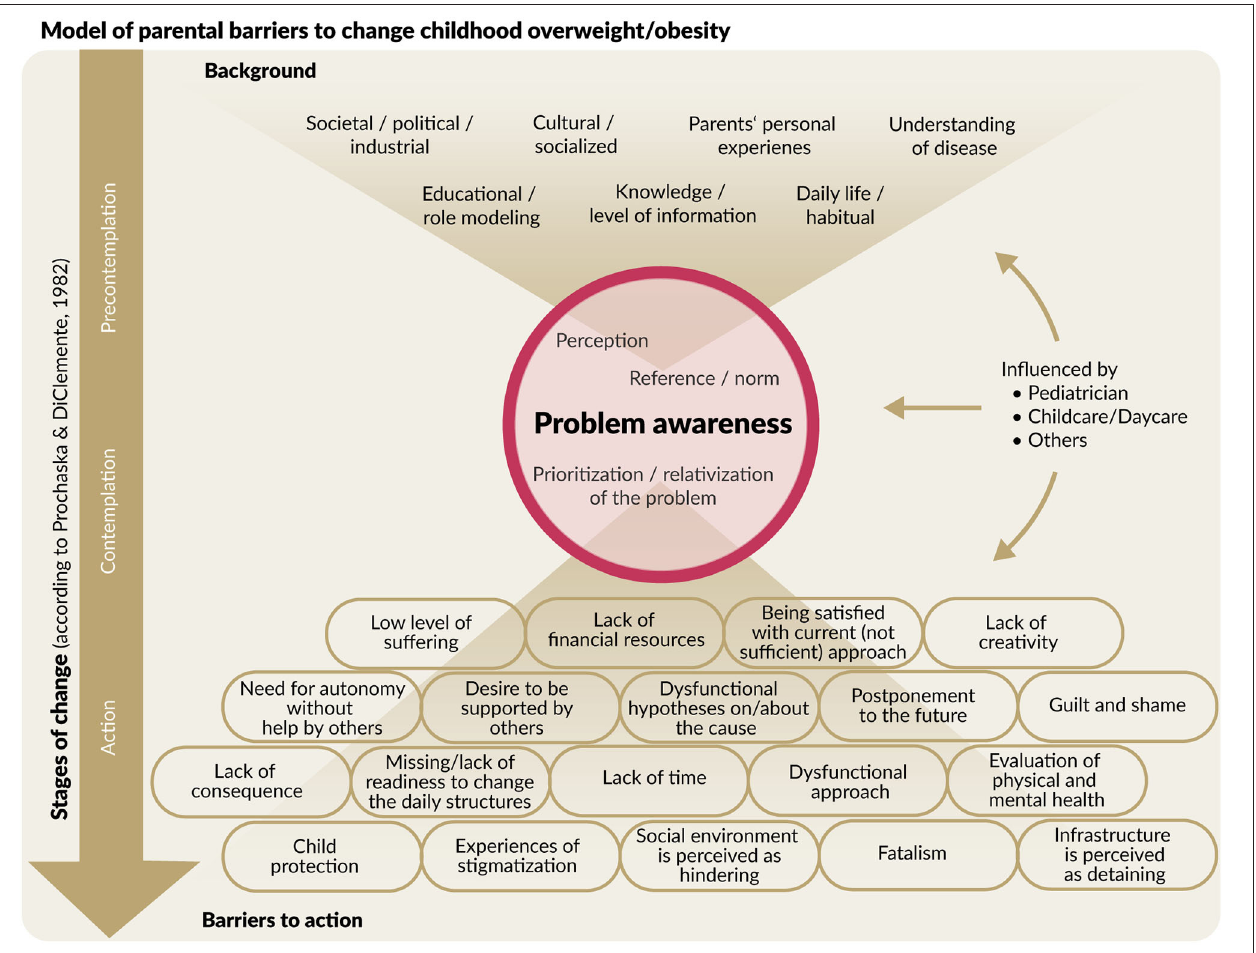
FIGURE 2 | Final model of parental barriers to change in their children’s overweight/obesity. Stages of change refer to the transtheoretical model (TTM) by Prochaska and Diclemente (1982)